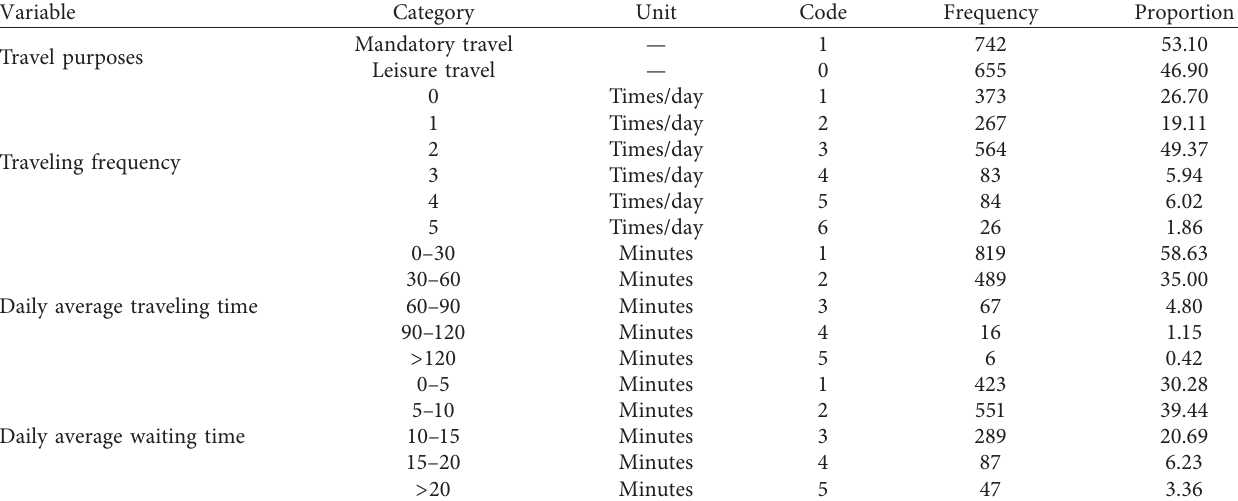
Table 2: Respondents’ travel activity attributes.